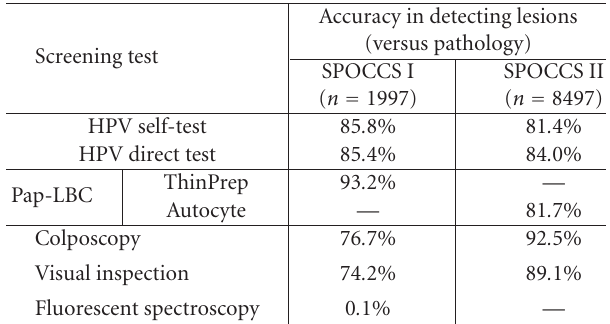
Figure 3: Cancer of the cervix—age-standardised incidence and